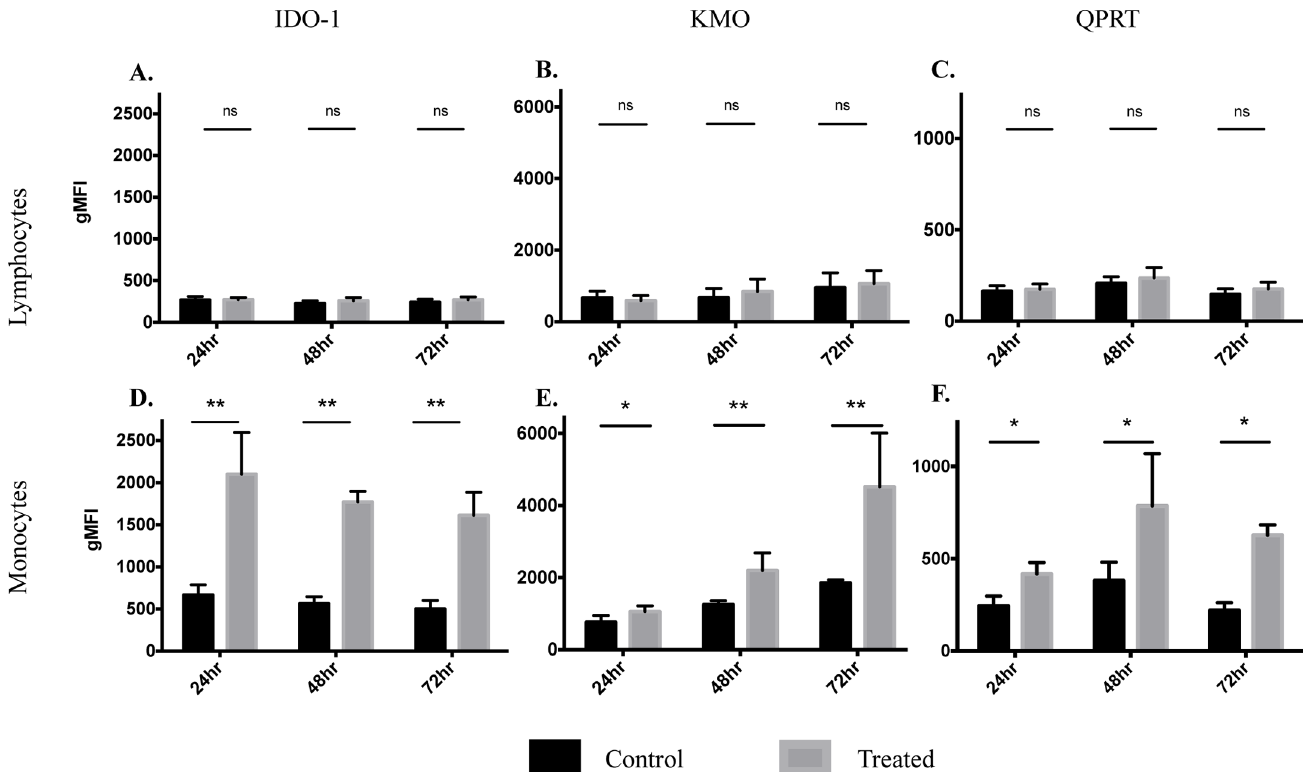
Fig 3. Geometric mean fluorescence intensity (gMFI) for IDO-1, KMO and QPRT expression. A summary of gMFI expression for the three KP enzymes in lymphocytes ( A-C ) and monocytes ( D-F ). Data is from 5 different biological samples with time-point (24, 48 and 72 hours) shown on the x axis. Black bars represent control experiments (untreated) and grey bars represent treated (500 IU/mL IFN- γ ). The y axis scale for gMFI has been normalized to improve comparison of expression for IDO-1, KMO and QPRT between lymphocytes ( upper row ) and monocytes ( lower row ). Data is presented as mean ± SEM, ns = no significant difference, * p < 0.01, ** p <